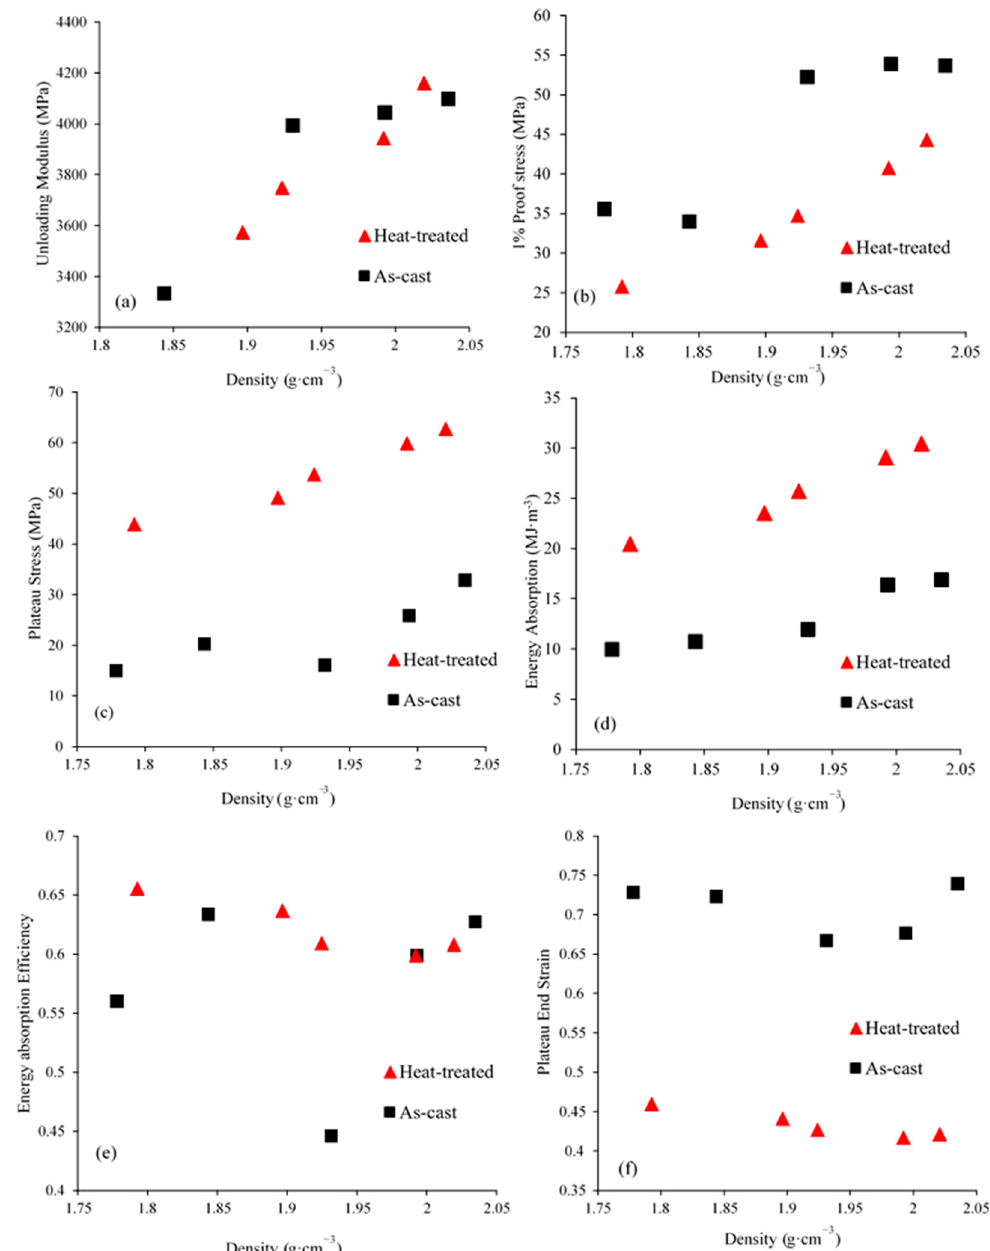
Figure 8. The principal mechanical properties of the as-cast and heat-treated ZA27 syntactic foam samples: ( a ) unloading modulus; ( b ) 1% proof stress; ( c ) plateau stress; ( d ) 50% strain energy absorption; ( e ) energy absorption efficiency and ( f ) plateau end strain versus sample density.